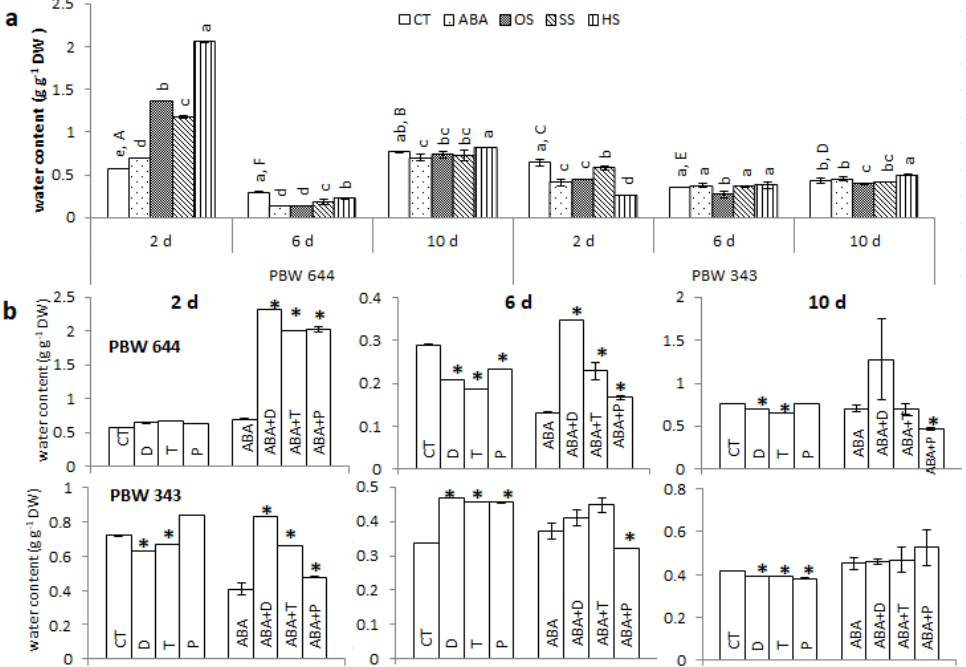
Figure 4 - Change of water content (WC) ( a ) and ROS/NO regulation of WC ( b ) during post-germination desiccation and rehydration of wheat cultivars PBW 644 and PBW 343. Rest is same as in Fig. 1 for a and Fig. 2 for b